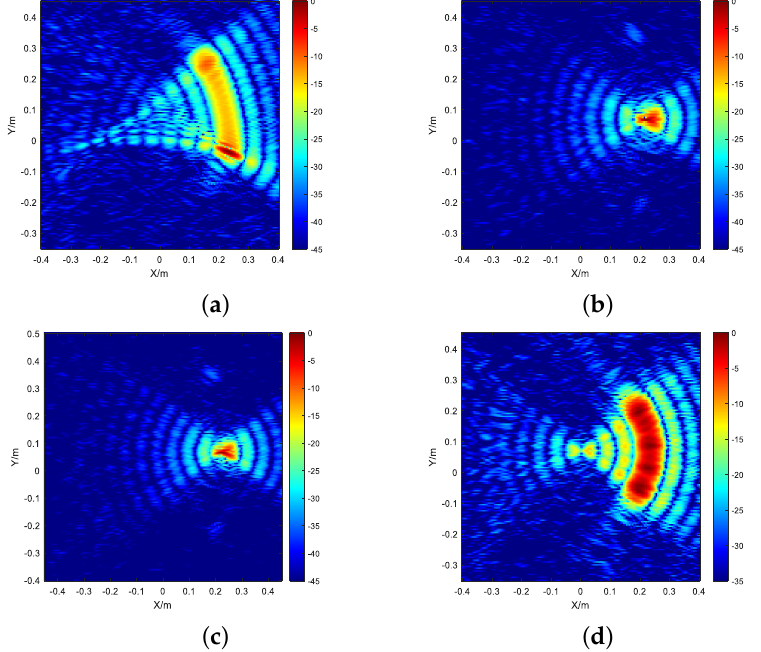
Figure 16. Real-data experimental imaging results of the metal arc cylinder for SNR ≈ 23 dB: ( a ) the BP result of the real trajectory; ( b ) the PGA result; ( c ) the MSE result; ( d ) the proposed SPA-GAN